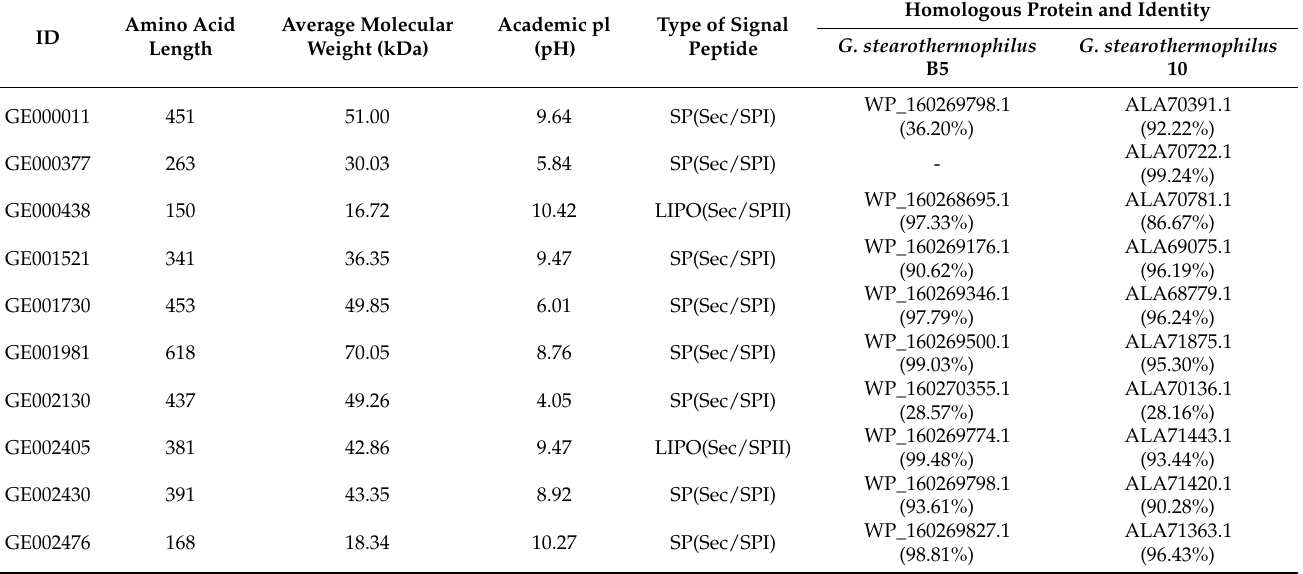
Table 4. Basic characteristics and homology analysis of proteases secreted by G. stearothermophilus